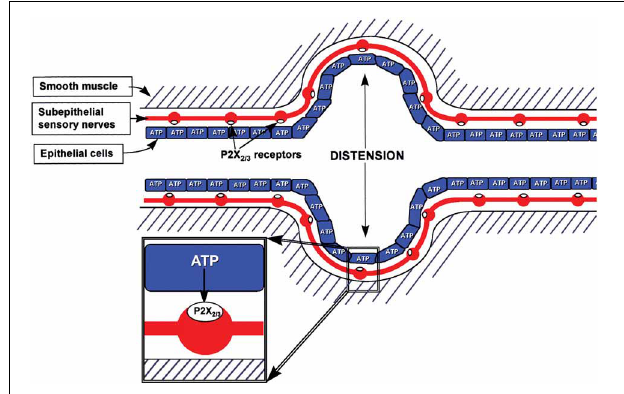
FIGURE 2 | Schematic representation of hypothesis for purinergic mechanosensory transduction in tubes (e.g., ureter, vagina, salivary and bile ducts, gut) and sacs (e.g., urinary and gall bladders, lung). It is proposed that distension leads to release of ATP from epithelium lining the tube or sac, which then acts on P2X 3 and/or P2X 2 / 3 receptors on subepithelial sensory nerves to convey sensory/nociceptive information to the CNS. [Reproduced from Burnstock (1999), with permission from